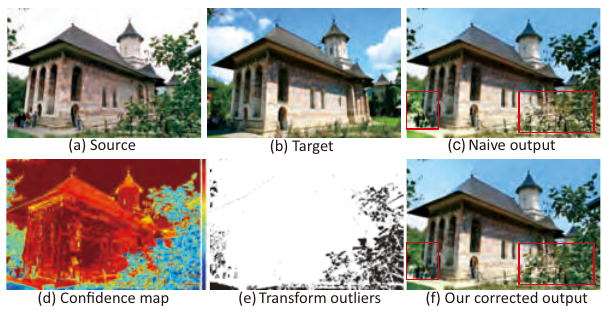
(f) Our corrected output(e) Transform outliers(d) Confidence map Fig. 3 Unreliable transforms result in distorted colors in the naive output (c). We compute a confidence map (d) to detect transform outliers after propagation. By removing the transforms with low confidence values (e) and leaving the associated source pixels’ colors unchanged, we have an output with correct colors (f), e.g., people and leaves (in the red